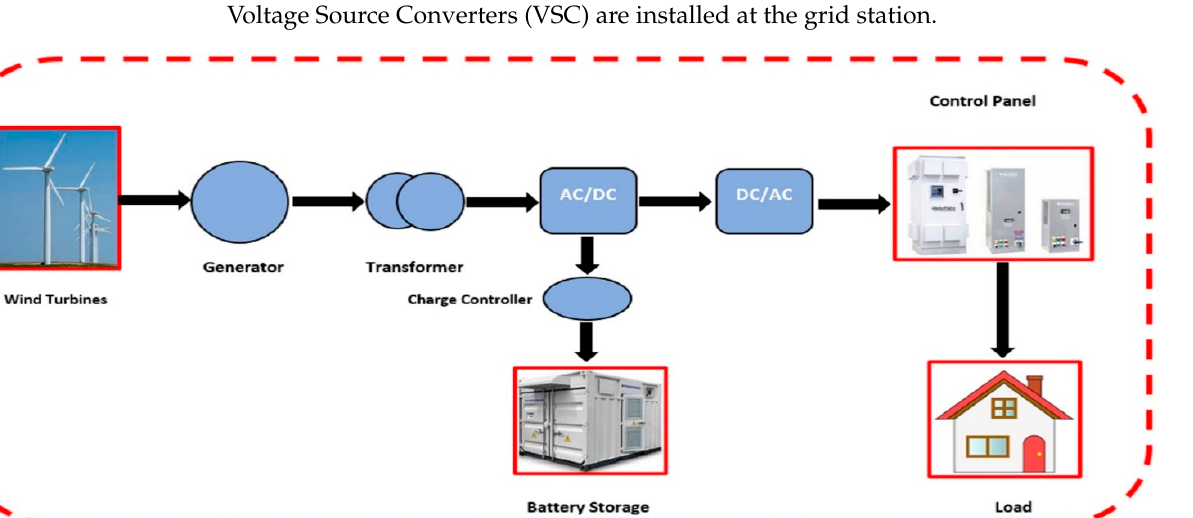
Figure 18 . Wind energy integration into the power system.